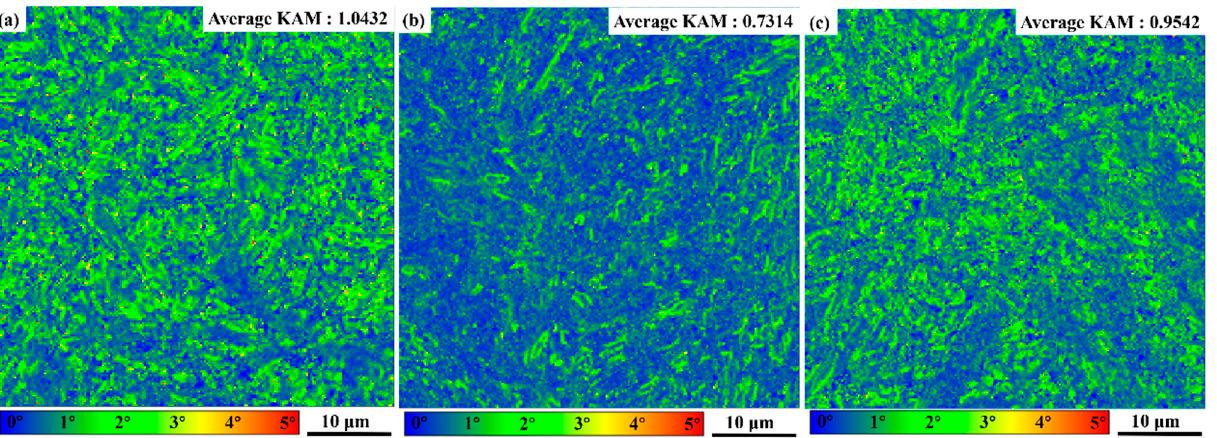
Figure 4. The Bright field TEM images of 35CrMo steel after tempering at different temperatures ( a ) and ( b ) 610 ◦ C, ( c ) 680 ◦ C, and ( d ) 740 ◦ C.